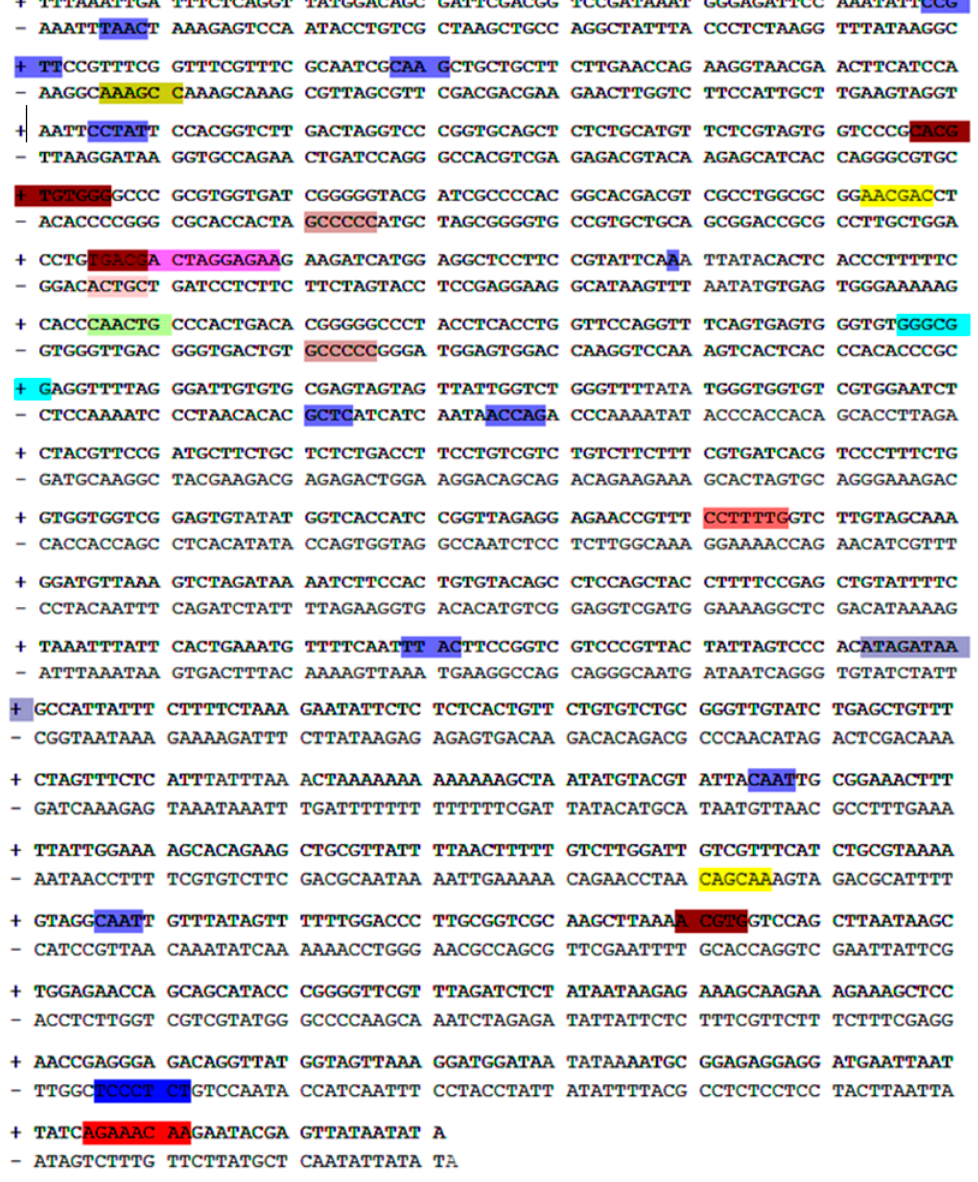
Figure 14. Promoter sequence of TPD1 gene; important motifs are highlighted in various colors. Table 2. Site name, position, sequence and function of primers of organisms.